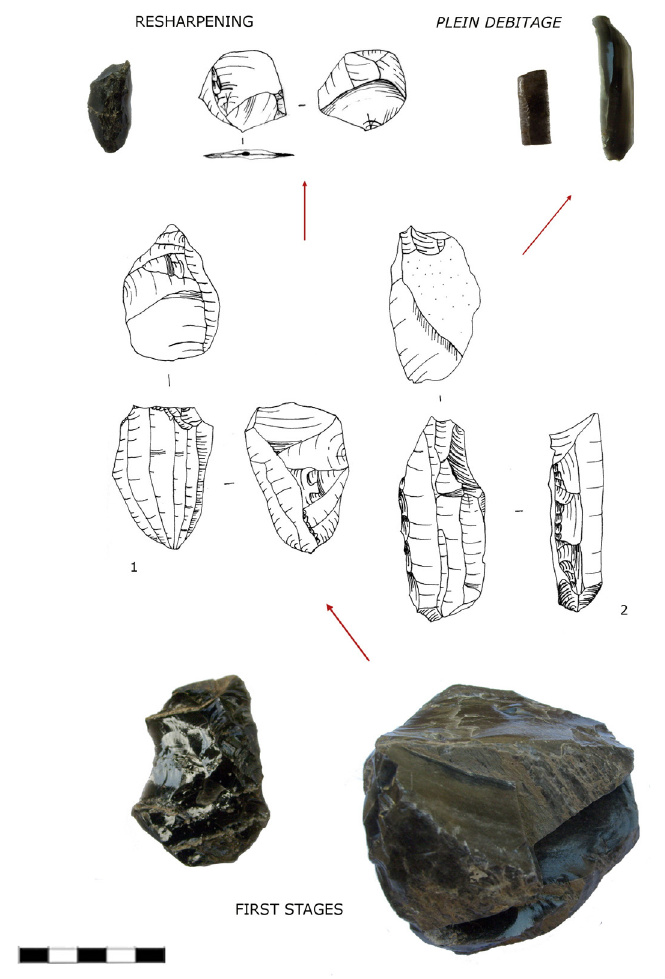
Figure 11. S. Martino. Chaîne opératoire of the obsidian assemblage from Diana levels. In the middle part there are pyramidal and prismatic shaped cores; in the lower part there is the obsidian raw